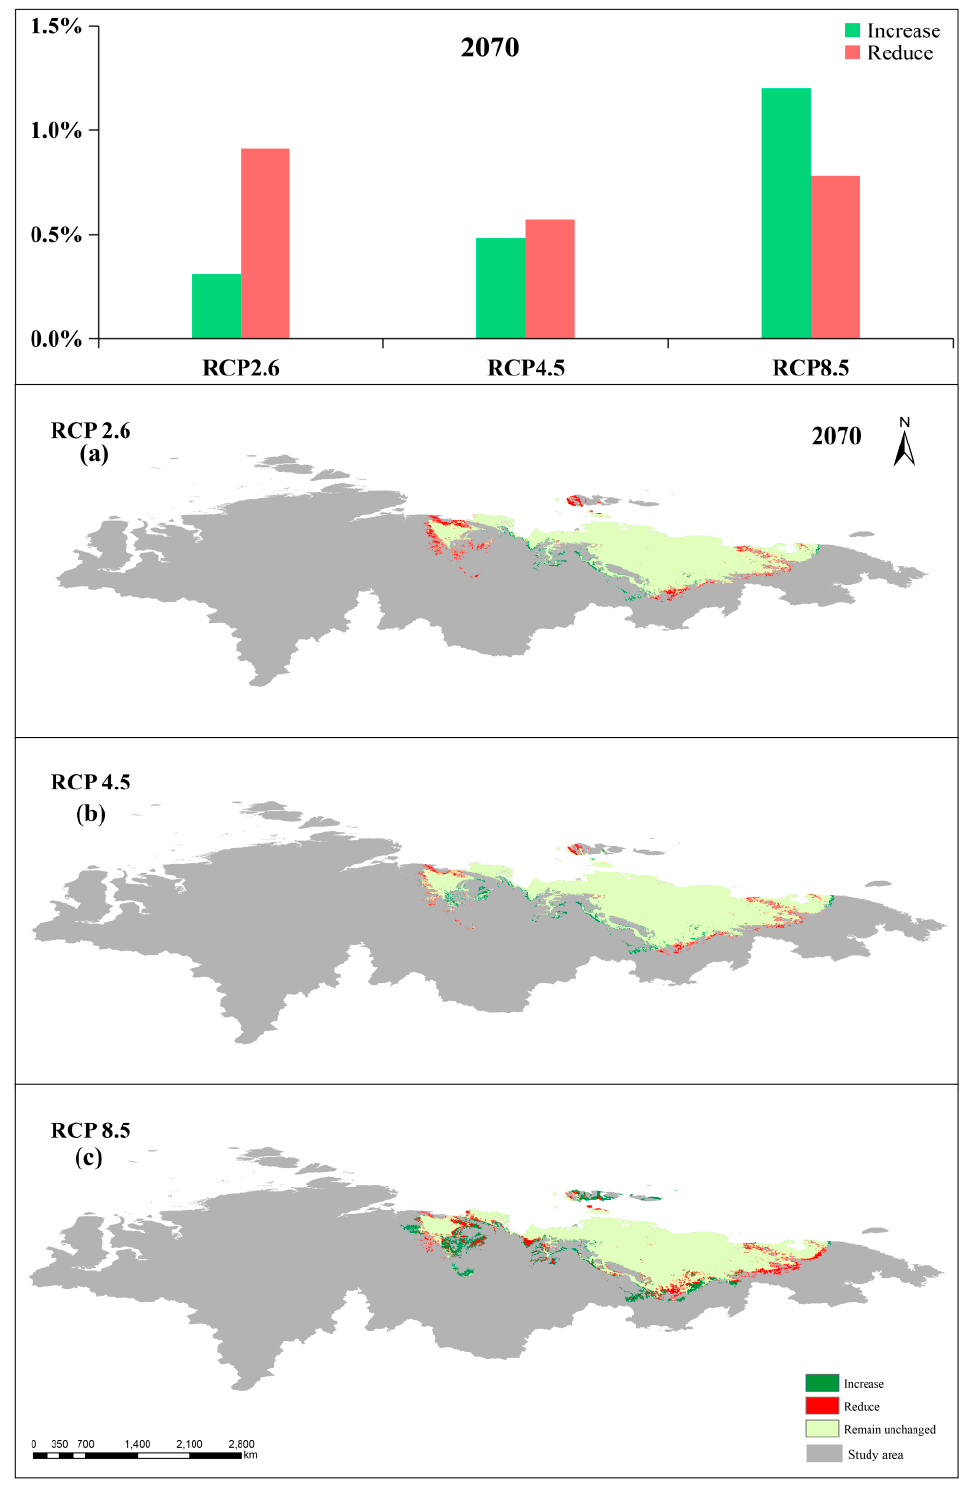
Figure 9. Increases and decreases in suitable breeding sites for lesser white-fronted goose under different climate change scenarios in 2070: ( a ) 0.31% increase and 0.91% decrease under the RCP2.6 scenario; ( b ) 0.48% increase and 0.57% decrease under the RCP4.5 scenario; and ( c ) 1.20% increase and 0.78% decrease under the RCP8.5 scenario. Red represents the decreased area, and green represents the increased area.